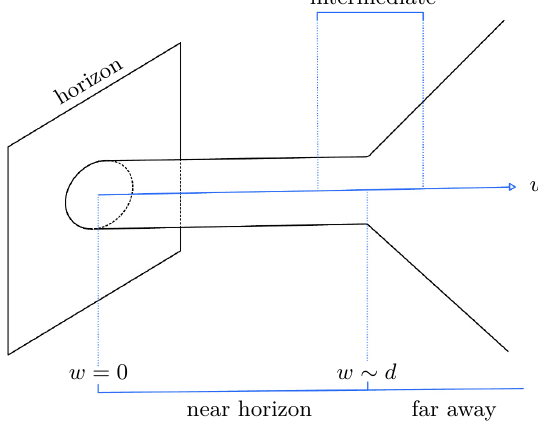
Figure 1 . The near horizon region captures the black hole physics for d (cid:29) 1 . This region corresponds to r − r 0 (cid:28) r 0 (or w (cid:28) d ), whereas the far away region corresponds to r − r 0 (cid:29) r 0 /d (or w (cid:29) 1 ). In the far away region one finds a Lifshitz vacuum with z (cid:29) 1 . This region is not of interest to us in this note. Notice that there is a range of interpolation, represented by the intermediate region. The relation between coordinates is given in